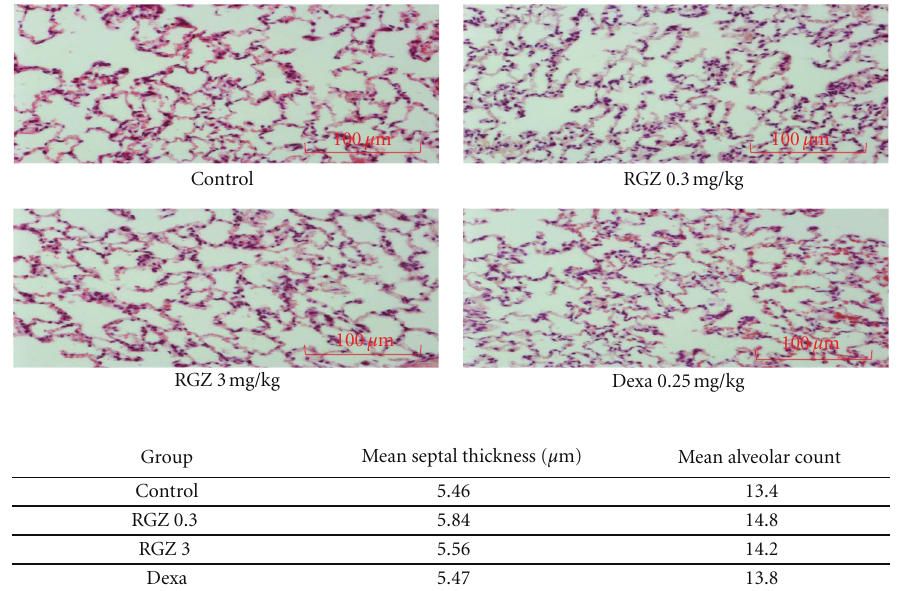
Figure 6: H&E staining of lung samples showed no significant di ff erences in the alveolar number and septal thickness at 20 weeks, between control and treated groups. Light microscopy images of the sections at 20x magnification are shown. P > 0 . 05 for all groups and n = 4 in each